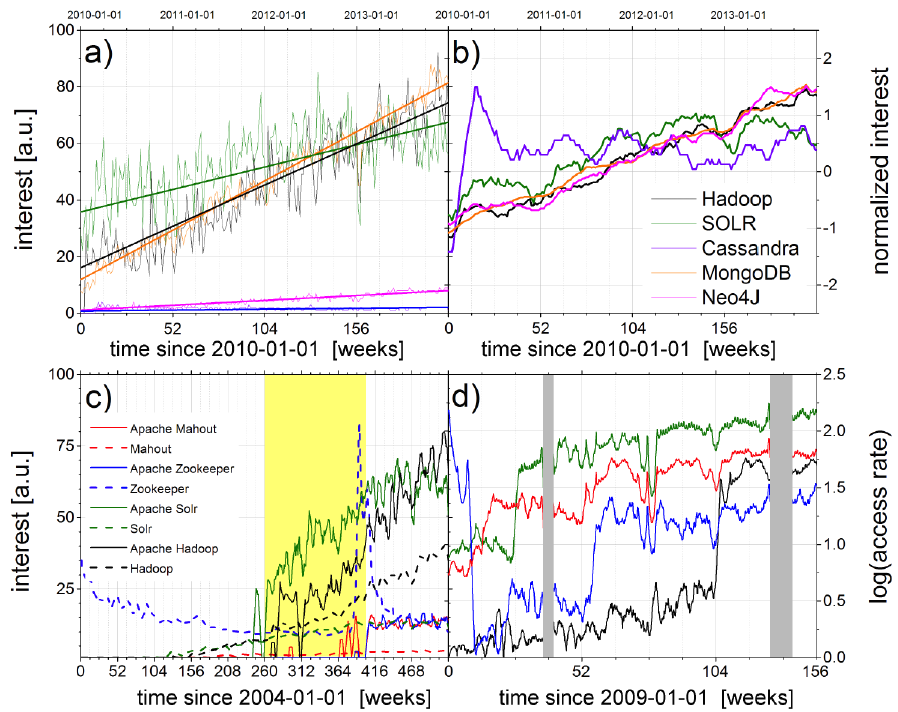
Fig 3. Relative attraction and trends based on Google Trends data (a, b, c) and on access-rate time series from Wikipedia (d) for names of NoSQL databases as search terms (see legends) versus time in months since (a, b) 2010-01-01, (c) 2004-01-01, and (d) 2009-01-01. The approximately linear slopes in (a) differ, and very strong fluctuations are found for Hadoop (black) and SOLR (green), so that the different curves can hardly be compared. In (b) the Google Trends data from (a) have been normalized for zero average and unit standard deviation to facilitate a comparison. However, ambiguous keywords can strongly influence the results as shown in in (c), where raw Google Trends data acquired simultaneously for eight different keywords (using an unofficial API software [31]) is shown. Here, the maximum at interest level 100 (arbitrary units from Google Trends) occurs only for one of the curves in 2015 and is not shown in the plot. Wikipedia access-rate data in (d), corresponding to the time range of the yellow box in (c), indicate a jump in user interest for pages about Apache Hadoop, Apache Zookeeper, and Apache SOLR, which was not visible in the Google Trends data. The gray boxes in (d) indicate times for which no Wikipedia access data is available for technical